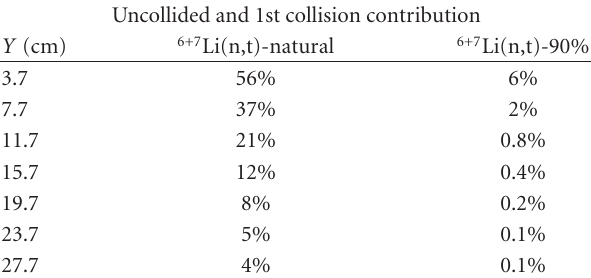
Figure 2: Tritium production rate for the natural and enriched Li pellets.